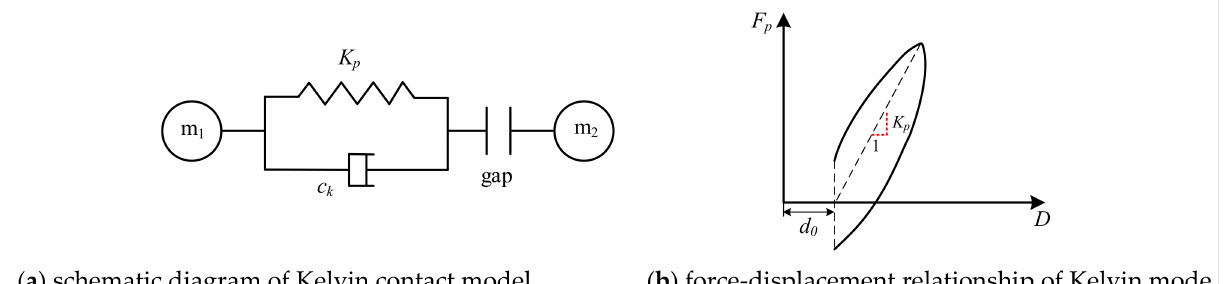
Figure 6. Kelvin model.